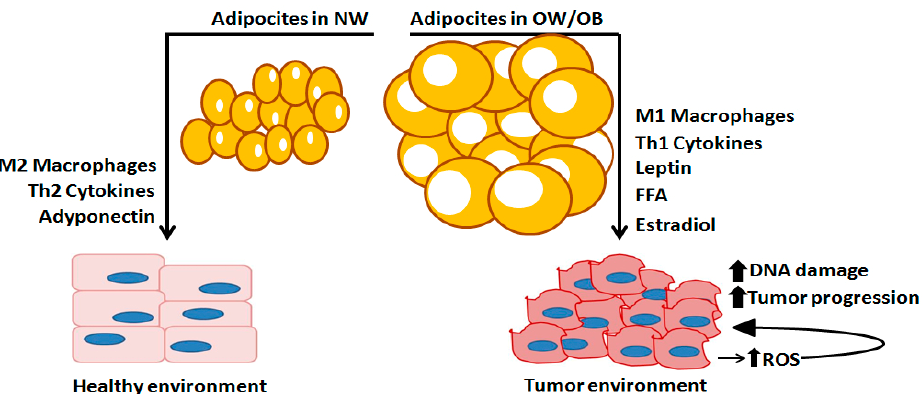
Figure 2. Adipose-related factors engaged to the initiation and progression of breast cancer. Normal adipose tissue, generally existing in “normal weight” (NW) subjects (%BF cutoff values between 8 and 20% for men and 14 and 23% for women), is characterized by smaller and less adipocyte cells and M2-polarized macrophages that release anti-inflammatory cytokines and adiponectin that contribute to normal breast cell development. In overweight (OW) and obese condition (OB), adipose tissue is characterized by larger size and more abundant adipocytes, releasing pro-inflammatory cytokines, M1-polarized macrophages, leptin, free fatty acids (FFAs), and estrogens, synthesized by aromatase enzyme. These factors act as mutagens stimulating the growth of tumor cells. A tumor environment produces more reactive oxygen species (ROS), which generate DNA damage, amplify and induce mutagenesis, tumor growth and progression. Therefore, the OW/OB condition provides a favorable microenvironment for adipose tissue to induce tumor establishment and progression.